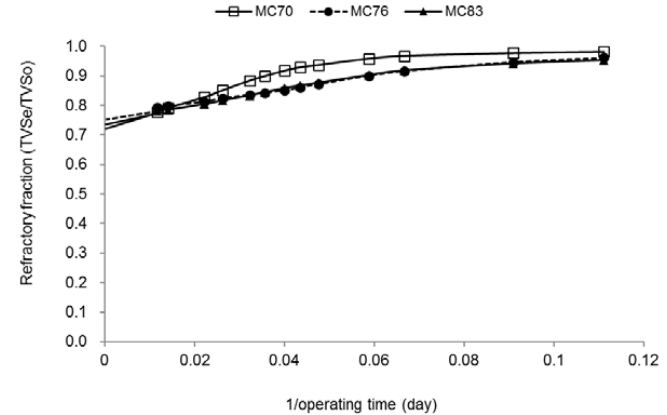
Figure 2. Ultimate biodegradability values of dairy manure during SS-AD. Digesters containing non-amended manure containing 70% MC (MC70) and manure amended to 76% and 83% MC (equivalent to the water holding capacity of dairy manure) (MC76 and MC83, respectively) were incubated at 37 ◦ C for 85 days. Values are means ( ± SE) of three replicates. TVSe: remaining volatile solids; TVSo: initial total volatile solids. Table 2. Ultimate biodegradability and volatile solids removal during SS-AD of dairy manure. Data represent means ± SE ( n = 3) ( a Biodegradable volatile solids removal = Removed biomass